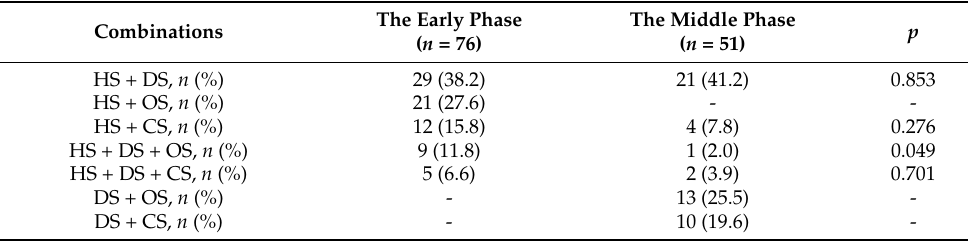
Table 4. Combinations and relative frequencies of multifactorial shock in different phases af- ter polytrauma.